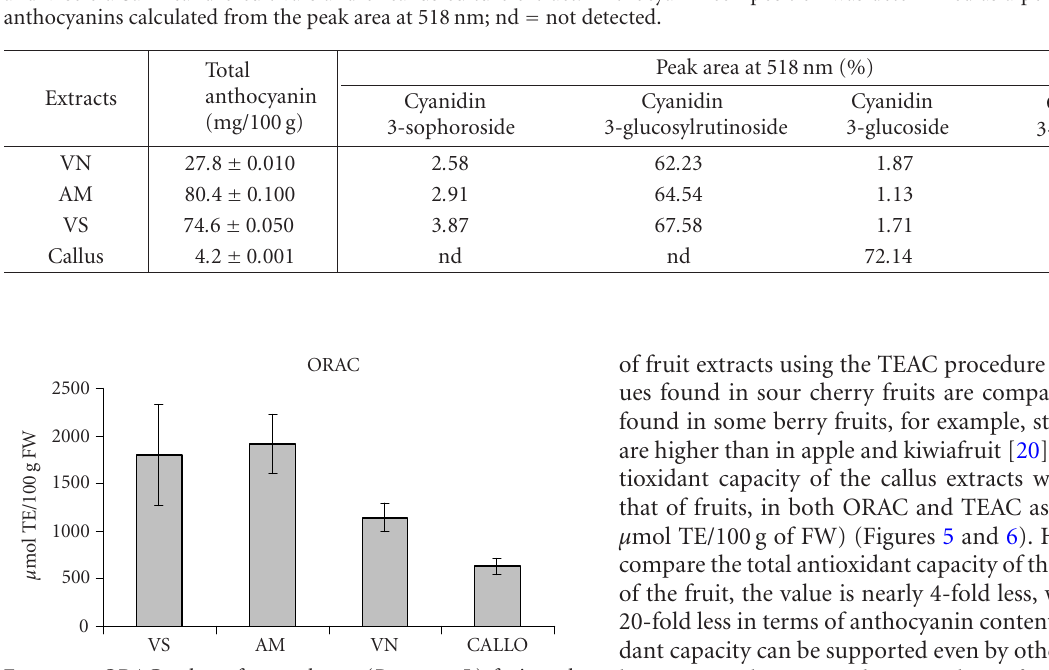
Figure 5. ORAC value of sour cherry ( P cerasus L) fruit and callus extracts. The results are expressed as micromole Trolox equivalents per gram of fresh weight. Data is expressed as means ± SD of two assays per extract. Fruits are taken from the cultivars Amarena Mattarello, Visciola Ninno, and Visciola Sannicandro. Callus has been generated in vitro from the leaves of sour cherry cv Amarena Mattarello.